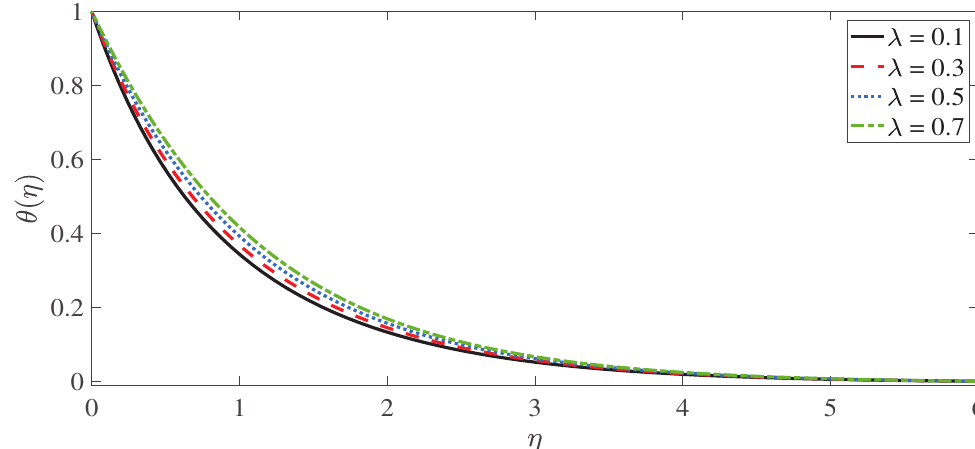
Figure 11. Temperature profile as a function of Eckert number λ